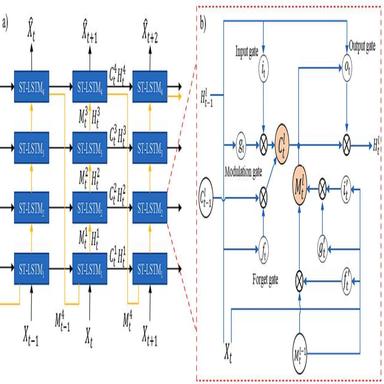
Architecture of (a) the predictive recurrent neural network (PredRNN) and (b) the Spatiotemporal LSTM (ST-LSTM) unit.